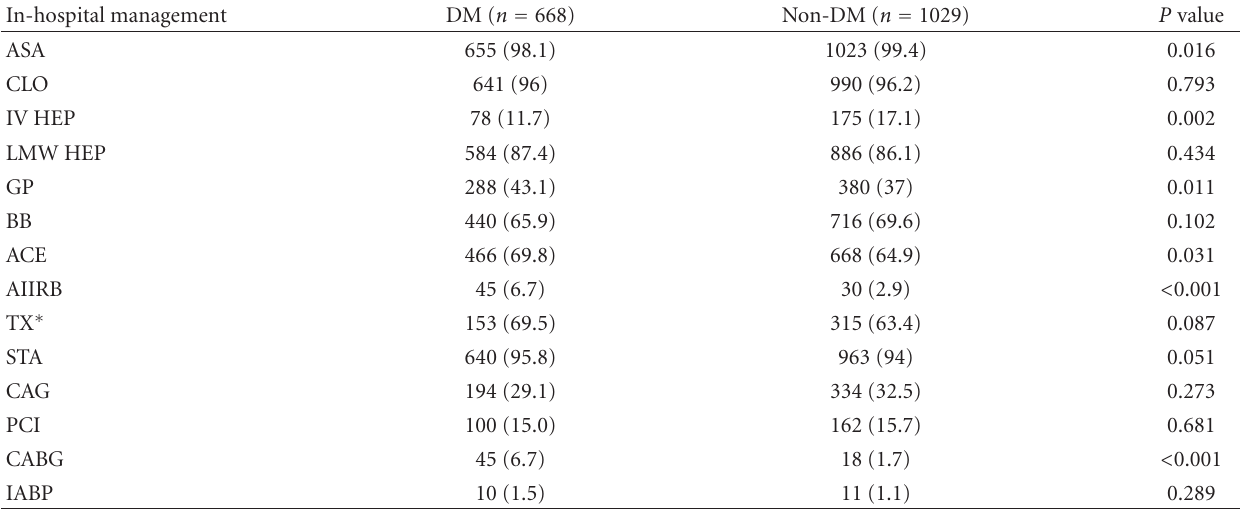
Table 2: In-hospital management of acute coronary syndrome patients with and without diabetes mellitus.